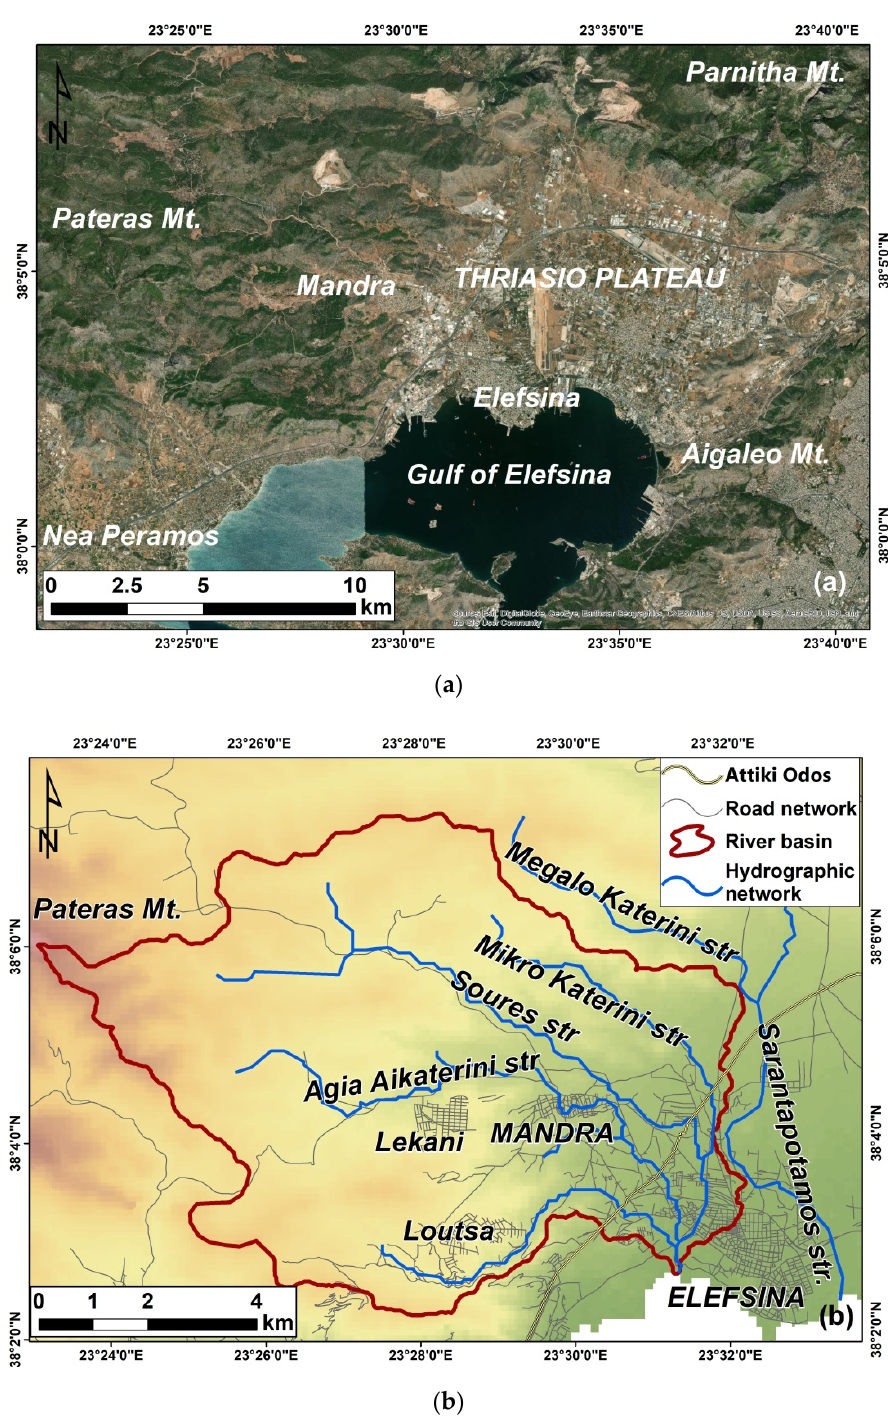
Figure 1. ( a ) Map of Mandra town in Western Attica and the neighboring areas. ( b ) The main drainage basins include the Soures and Agia Aikaterini streams that pass through the buildings and